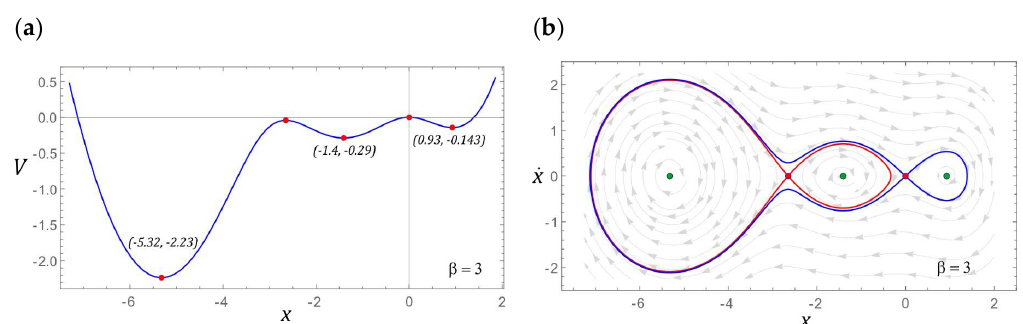
Figure 11. The location of fixed points is shown as ( a ) potential characteristics, ( b ) phase plane with the corresponding homoclinic orbits.